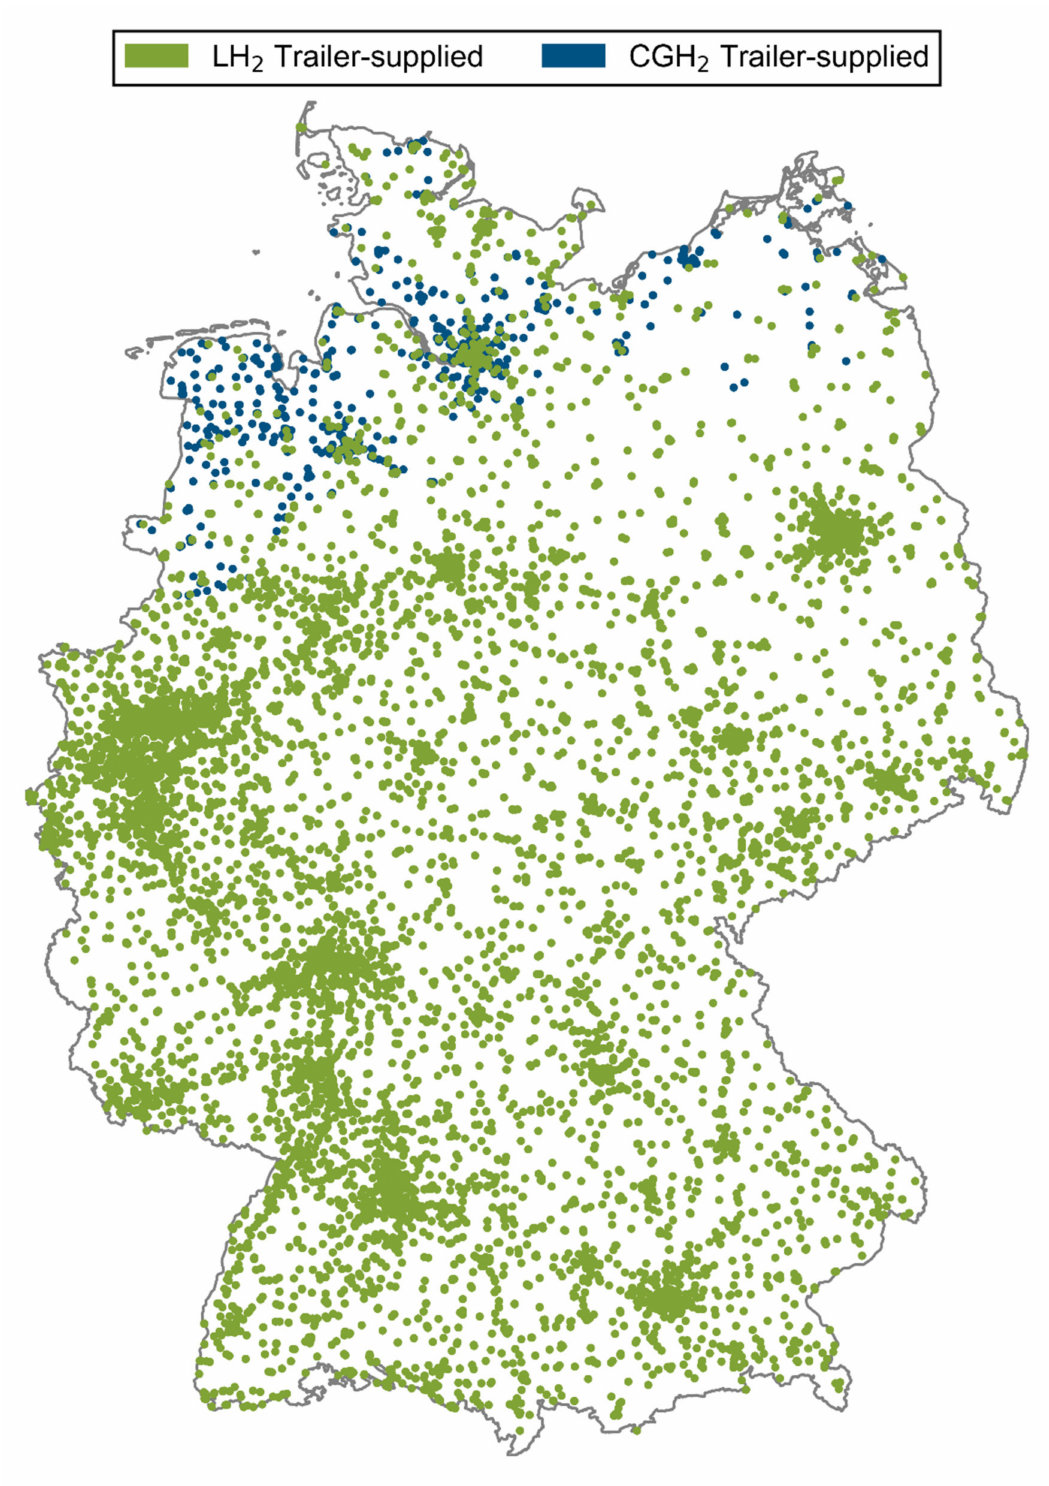
Figure 7. Results of the distribution optimization for each fueling station as a function of the transport